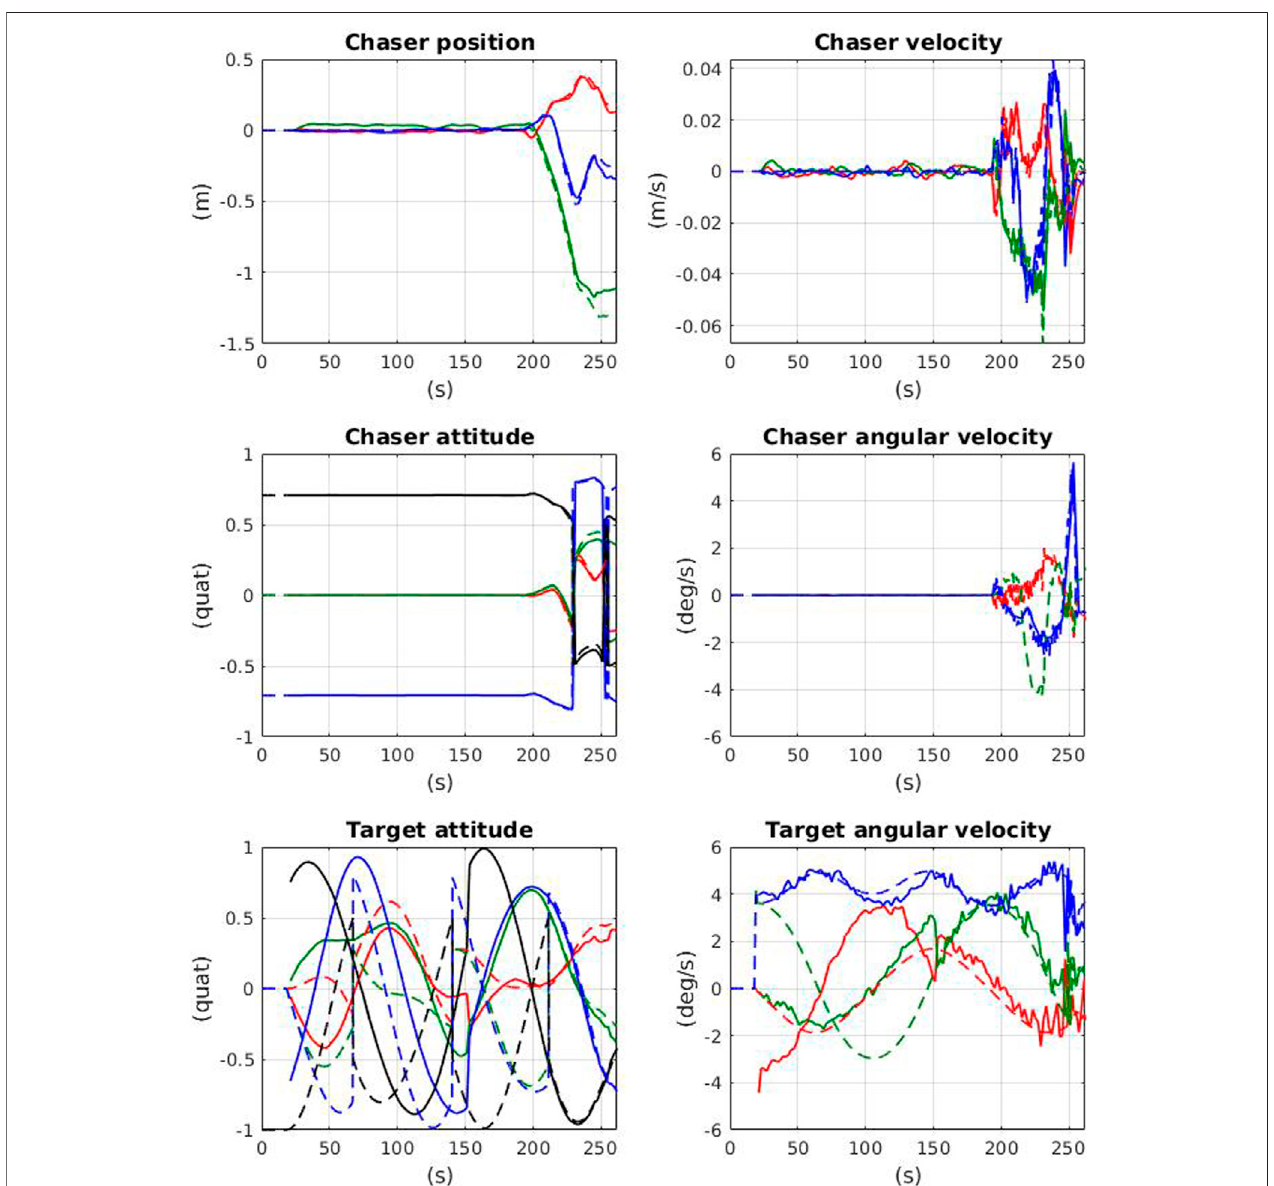
FIGURE 10 | Chaser and Target state estimates over the time-history ofthe full pipeline demonstration. Solid lines indicate estimated values, dashed lines indicate simulator truth. Notice the “ snap ” that occurs in the Target estimates when the principal axes are determined ( ∼ 150 s).